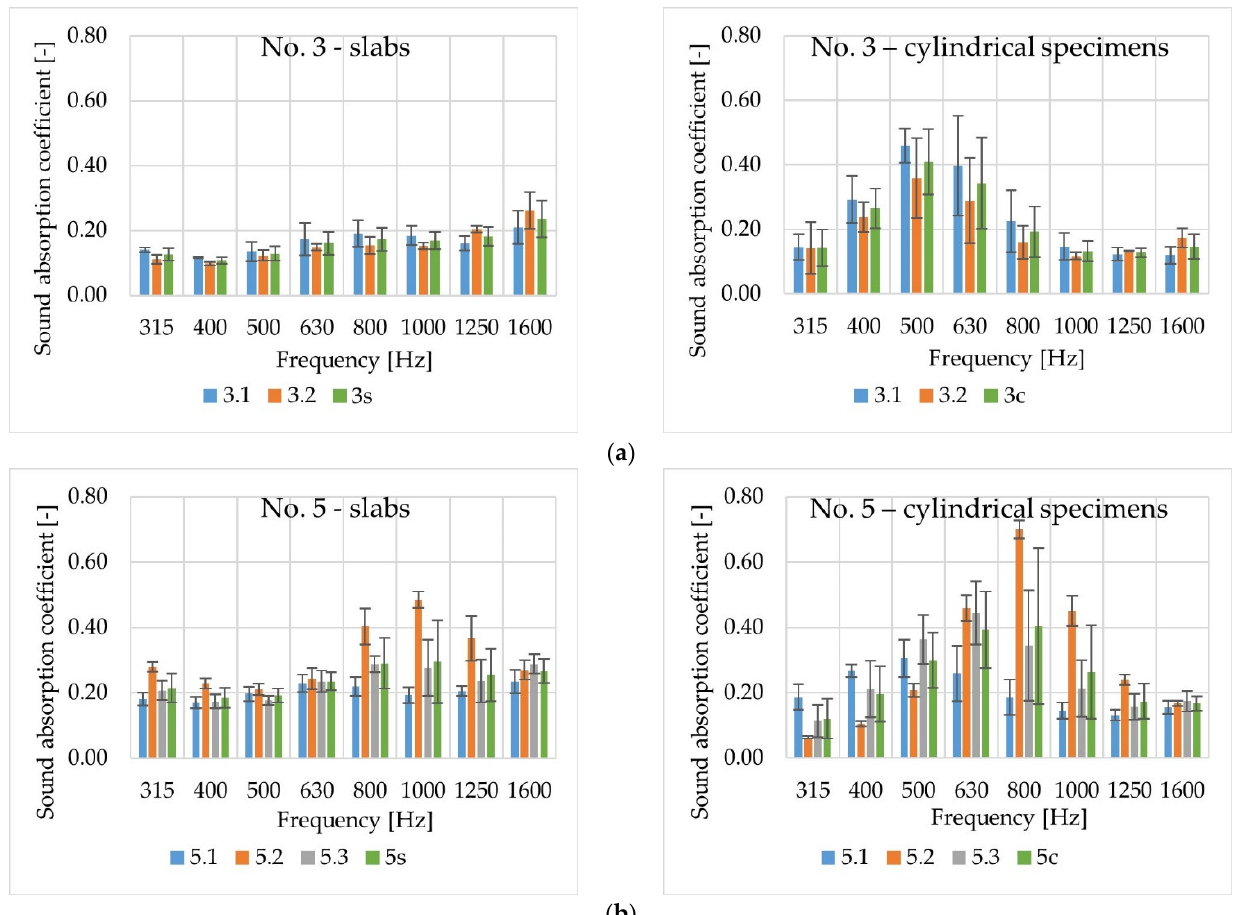
Figure 8. Sound absorption coefficients of poroelastic mixtures No. 3 ( a ) and No. 5 ( b ). A comparison of average values of sound absorption coefficients obtained for test slabs (labelled as 1s–7s) is shown in Figure 9, and for cylindrical specimens (1c–7c) in Fig- ure 10. In the case of slabs, the highest values were obtained for mixture No. 7 and—